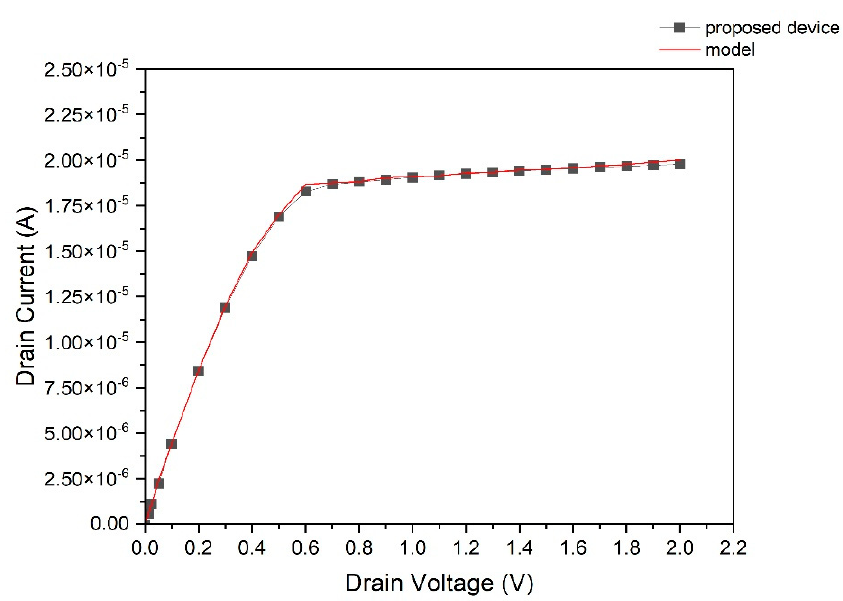
Figure 6. Output characteristic curves: TCAD simulation of the device used in this study and the traditional device model.